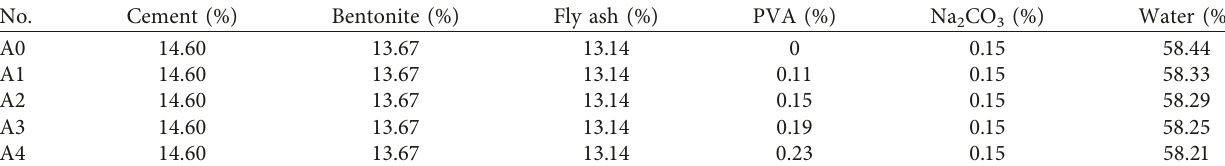
Table 3: The amount of each slurry component.